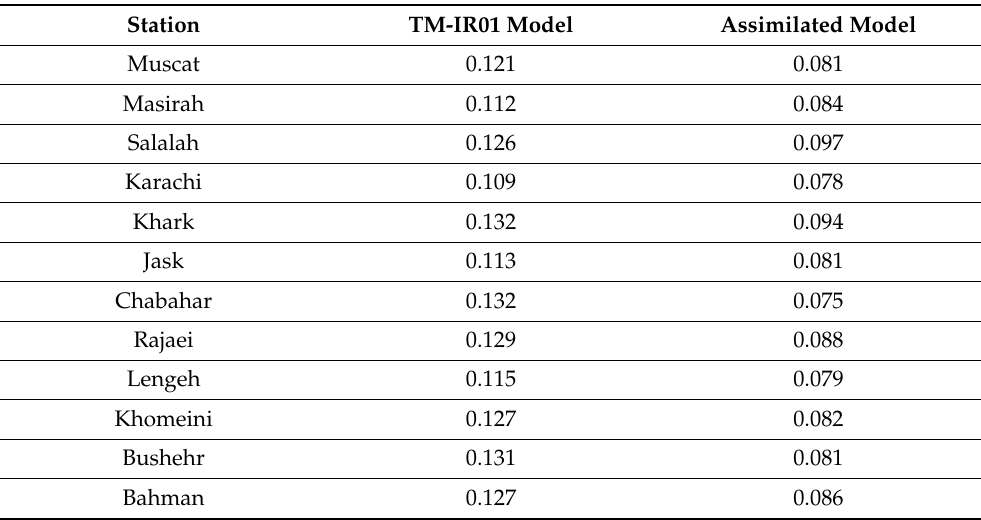
Table 6. RMSE results between SLH of tide gauge stations and TM-IR01 model, as well as assimi- lated model. Station TM-IR01 Model Assimilated Model Muscat 0.121 Masirah